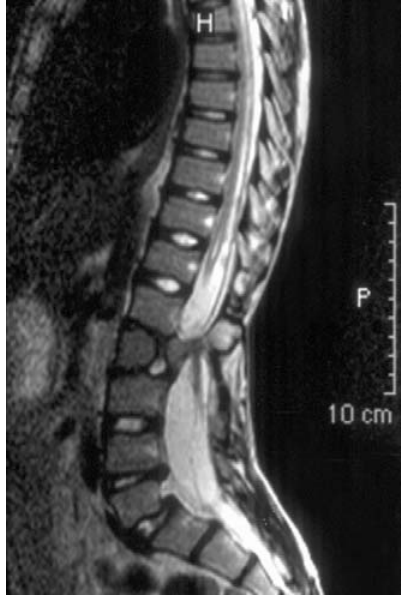
FIGURE 4. T2-weighted fast spin echo midsagital image showed bony spur crossing spinal canal at L2 level. Hydromyelia at upper segment was also